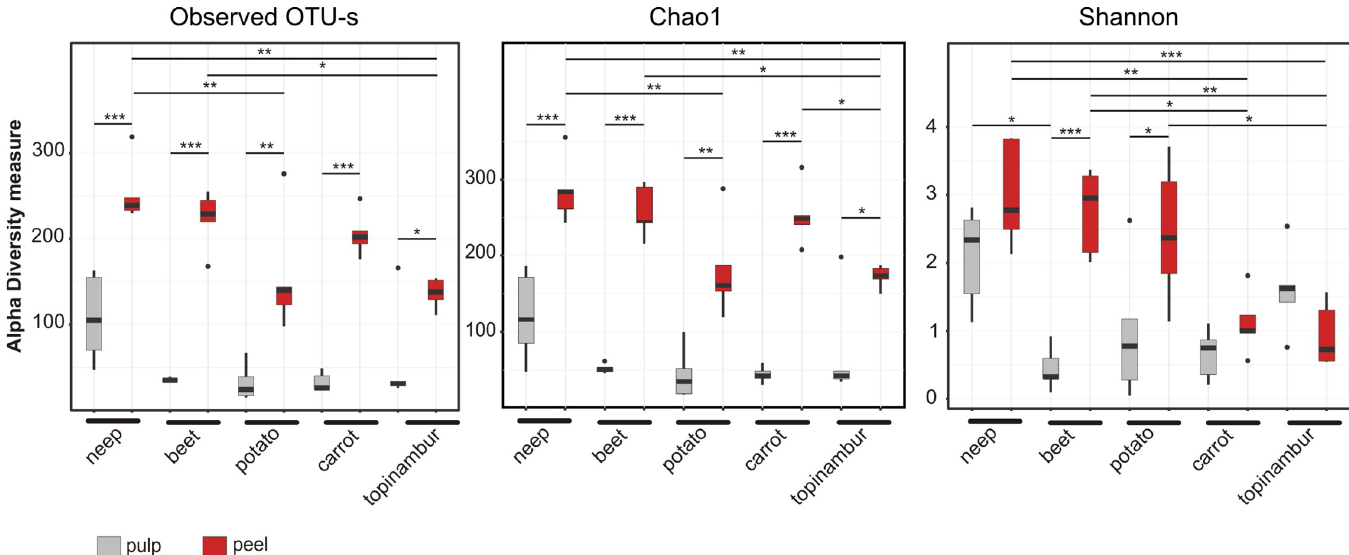
Fig 1. Estimates of the alpha diversity of the bacterial communities in root vegetables. Richness is based either on the number of observed OTUs (Observed OTU-s) or the estimated Chao1 index (Chao1) and the diversity is based on the Shannon index (Shannon). Significant differences between peels and pulps (following the Tukey post hoc test) are indicated at the top of each box: ��� P < 0.001; �� P < 0.01; � P < 0.05.